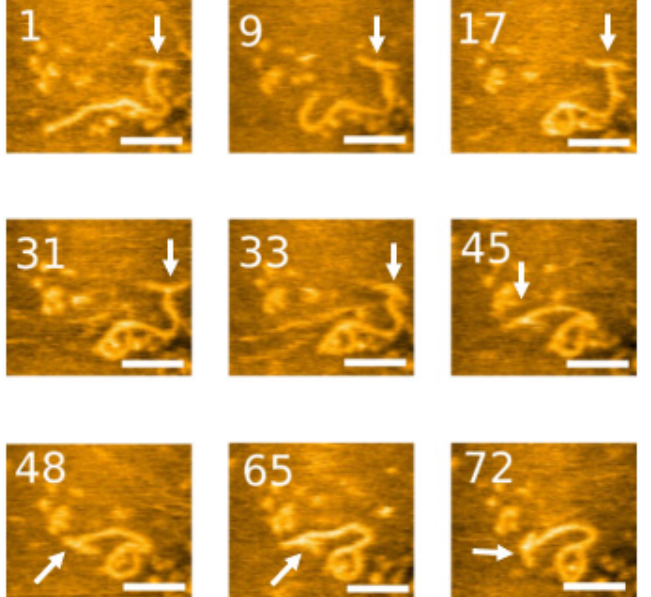
Figure 4. High-speed AFM imaging of labeled DNA substrate. 3WJs are indicated with arrows. Scale bar indicates 40 nm. The numbers in each image are their frame number in the movie file. The complete set of frames can be visualized in Movie S1. The numbers on the snapshots indicate the frame number. A frame is taken every 600